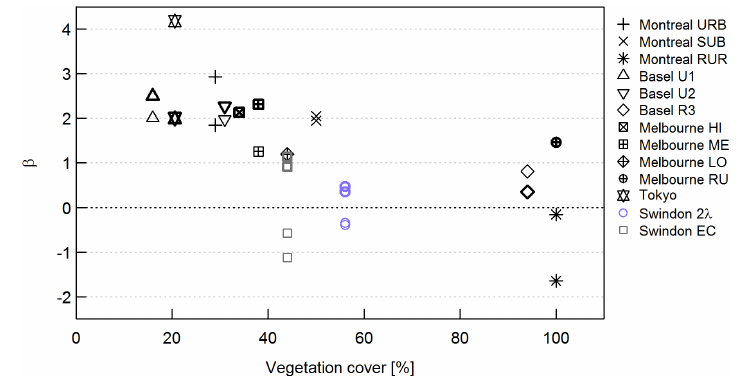
Figure 9. Observed daytime Bowen ratios for summer (bold) and winter months versus plan area vegetation cover at sites in Montreal (Bergeron and Strachan, 2010), Basel (Christen and Vogt, 2004), Melbourne (Coutts et al., 2007), Tokyo (Moriwaki and Kanda, 2004) and Swindon (this study). See references for details of the